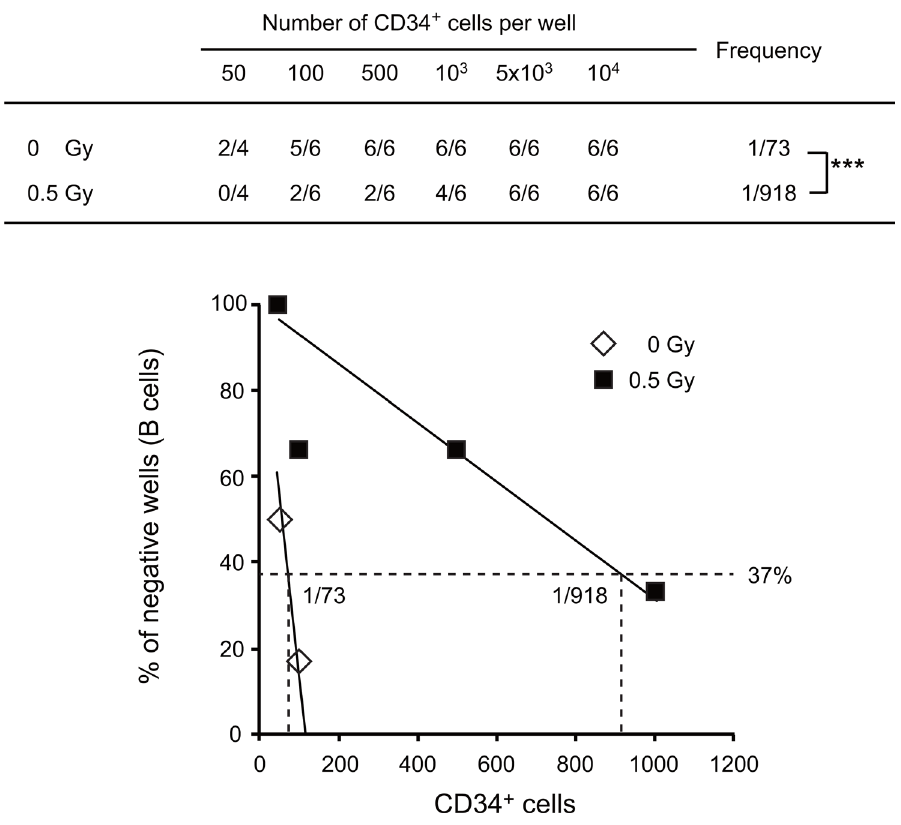
Fig 5. In vitro differentiation of B cells from human HSPCs irradiated in humanized mice. Frequency of B cell-producing CD34 + HSPCs irradiated in humanized mice. Human CD34 + HSPCs were recovered from the primary recipients at 2 weeks post-irradiation. Graded numbers of purified CD34 + HSPCs (50, 10 2 , 5 x 10 2 , 10 3 , 5 x 10 3 , 10 4 cells) were co-cultured with TSt-4 stromal cells in the presence of SCF, IL-7 and Flt3L (10 ng /ml each) for 4 weeks. Generation of CD19 + B cells was determined by flow cytometric analysis. The frequency of B – cell producing HSPCs was calculated using L-Calc software. The % of wells with B cell production and frequency of B-cell producing CD34 + HSPCs are summarized in the table and each data is plotted in the bottom panel. *** P < 0.001. The frequencies in non-irradiated and irradiated cells were compared by the χ 2 -test for a 2 x 2 contingency